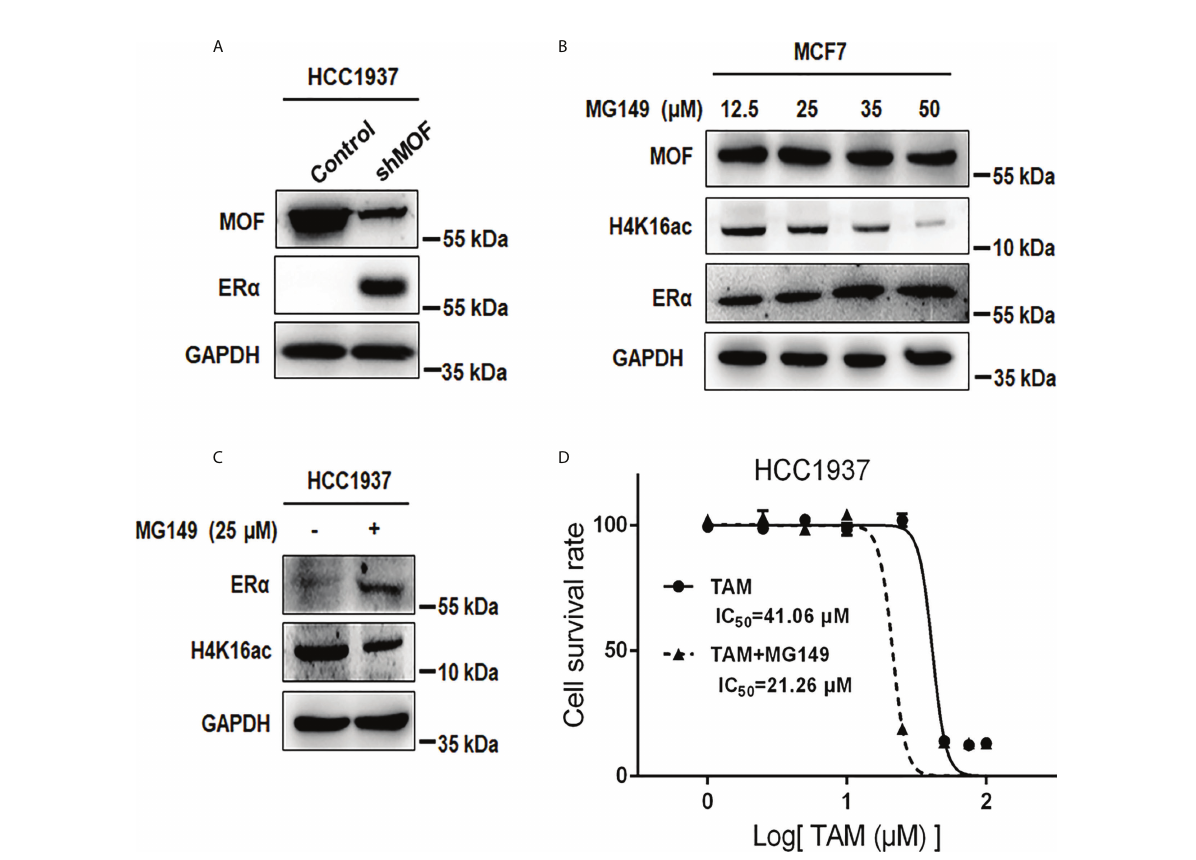
FIGURE 7 Effects of MOF inhibition on ER a protein expression and cell viability in ER a − HCC1937 cells. (A) MOF knockdown restored ER a protein abundance in ER a − HCC1937 cells transfected with pGPU6-shMOF plasmid as determined by Western blotting. (B) Different concentration of MOF inhibitor MG-149 was applied to examine its enhanced effect on ER a protein expression in MCF7 cells. (C) ER a protein expression was reactivated by 35 m M MG149 in ER a − HCC1937 cells. (D) Cell viability assay was performed to investigate the effect of MG149 on the sensitivity of ER a − HCC1937 cells to tamoxifen (TAM) treatment. IC 50 was calculated to compare the combinatory effect of TAM and MG149 with TAM alone treatment for 24